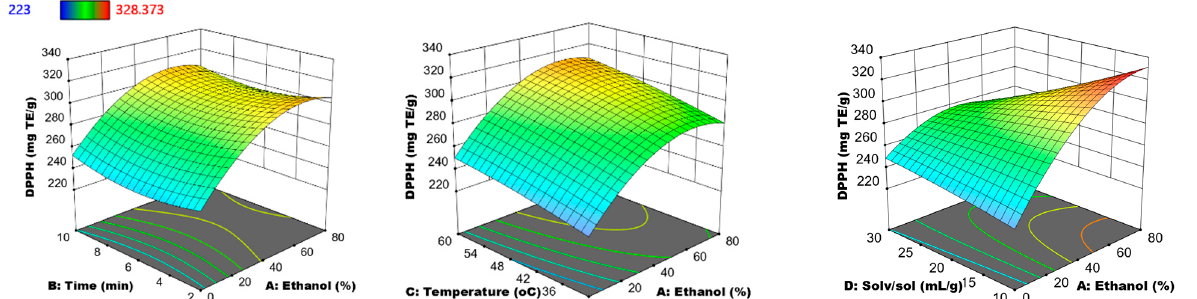
Figure 4. Response surface plots showing the combined effects of the UAE parameters (% ethanol- time, % ethanol-temperature, and % ethanol solvent-to-solid ratio) on the extraction yield, total phenolic content, ABTS, and DPPH radical scavenging activity by keeping the two independent variables constant at medium levels.